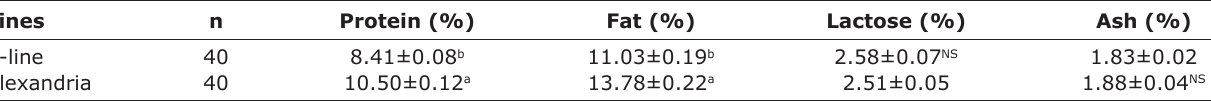
Table-2: Means and standard errors of MC for V-line and Alexandria line rabbits during the 3 rd week of lactation. Lines